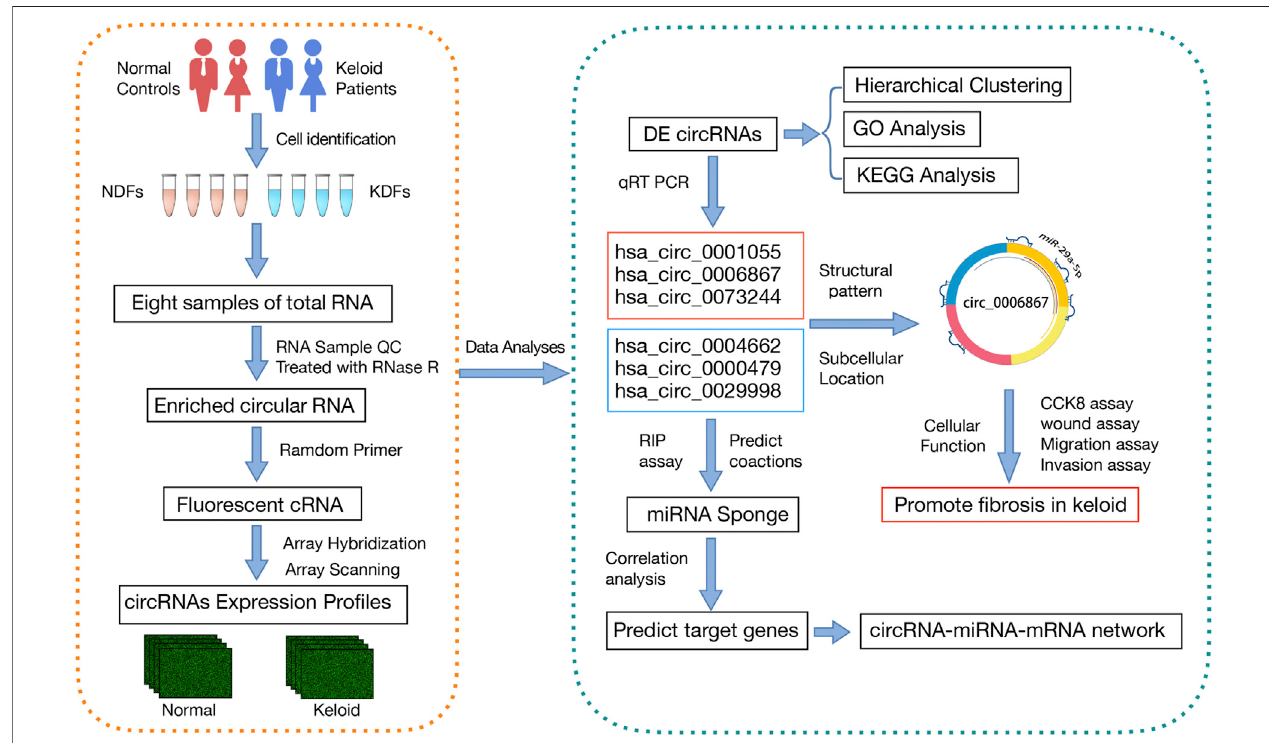
FIGURE 1 | Detailed fl owchart of the entire study. First, microarray analysis was performed to explore DE circRNAs in KDFs and NDFs. Then, GO and KEGG pathway analyses showed the potential functions of the DE circRNAs. six circRNAs were then veri fi ed by qRT – PCR, and a circRNA-miRNA-mRNA network was established for the validated circRNAs. Finally, we explored the cellular function and potential mechanism of hsa_circ_0006867.